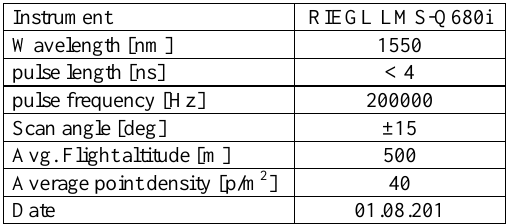
Figure 1. Overview of implemented processing steps for ALS and IS data combination. Rectangles point to processing units and parallelograms are products.